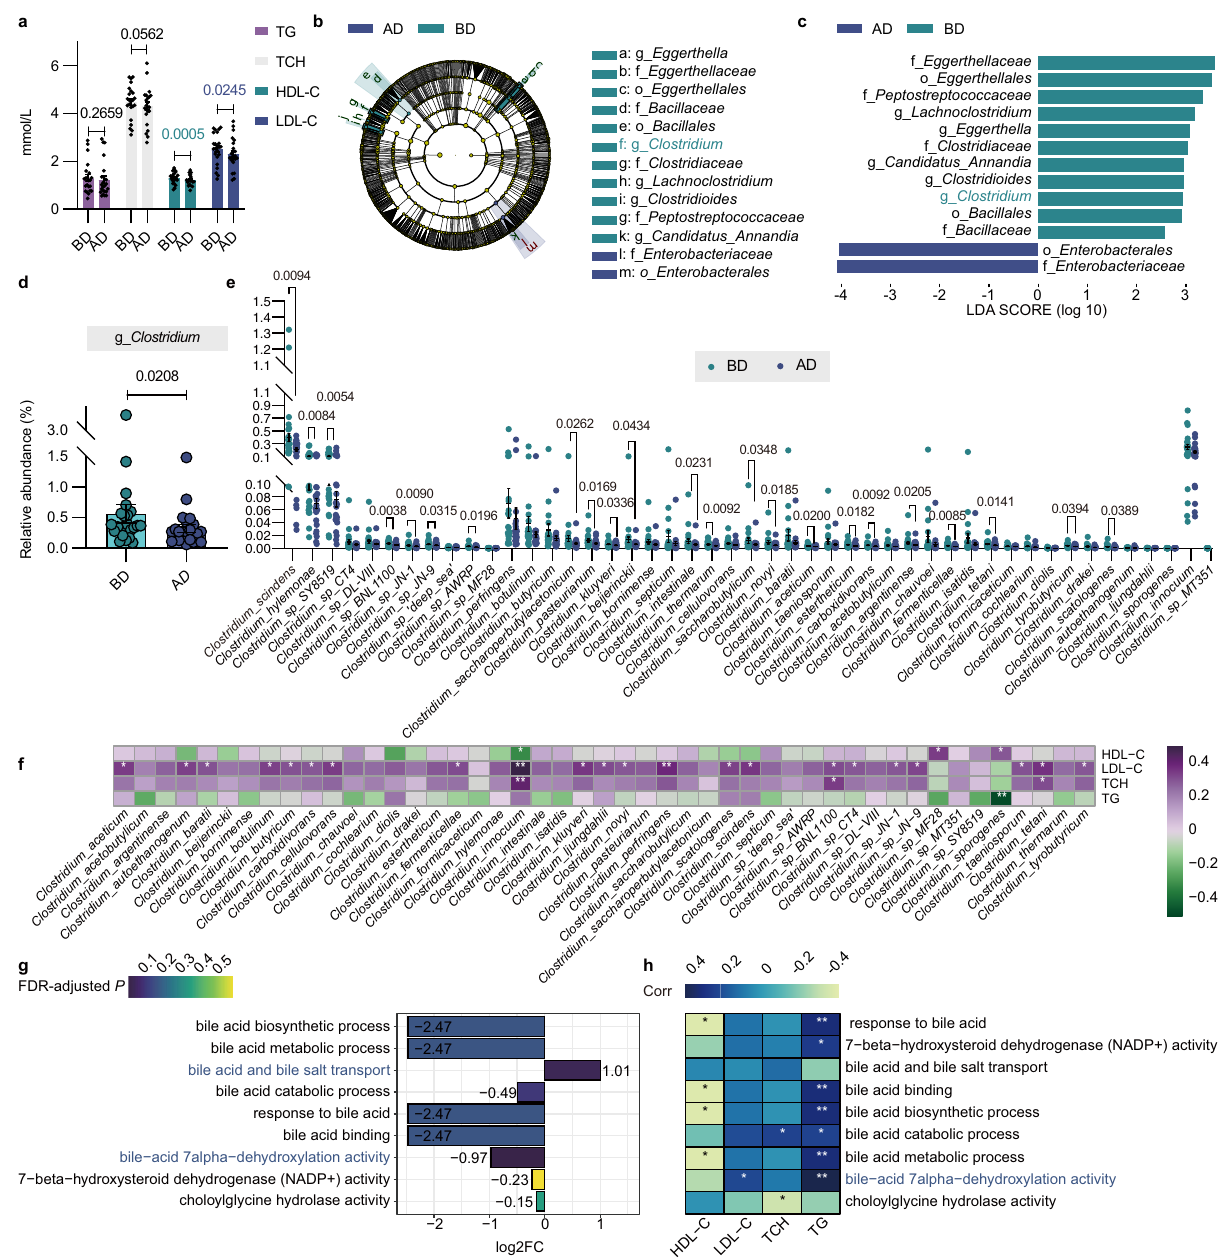
Fig. 6 | DSF improves blood lipid metabolism and reduces Clostridium -medi- ated7 α -dehydroxylationactivityinhumans.a BloodlipidfeaturesincludingTG, TCH, HDL-C, and LDL-C levels in BD and AD groups. Differences in data between 2 groups were calculated by two-sided paired t test. b , c Cladograms generated by LEfSedepictingtaxonomicassociationbetweenmicrobiomecommunitiesfromBD and AD groups (LDA>2.5). Green and blue bars indicate taxa predominant in BD and AD groups, respectively. d Abundance of the genus Clostridium between BD and AD groups FDR-adjusted P -value calculated by LinDA was shown. e Different species abundance of Clostridium in BD and AD groups. FDR-adjusted P -values calculatedbyLinDAwereshown. f Heatmapofthecorrelationsbetweenthespecies of Clostridium andbloodlipidfeaturesinBDandADgroups.Thecorrelationswere analyzed using Spearman ’ s correlation (two-sided). FDR-adjusted P <0.05 (* P < 0.05 and ** P < 0.01) was shown. g Barplot illustrating log2FoldChange